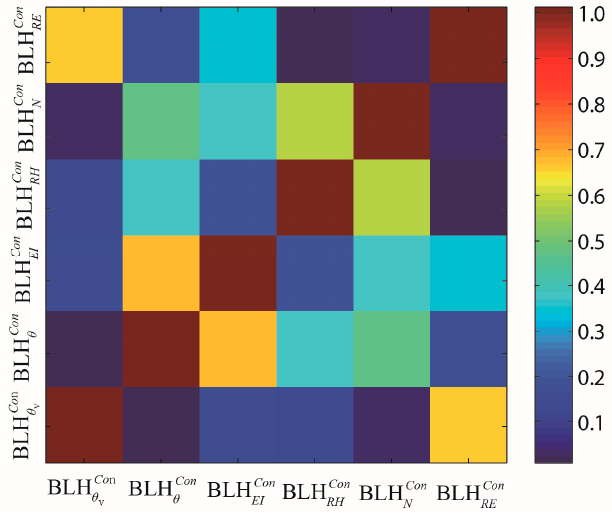
Figure 5. Cross-correlations between convective BLHs from six different methods.